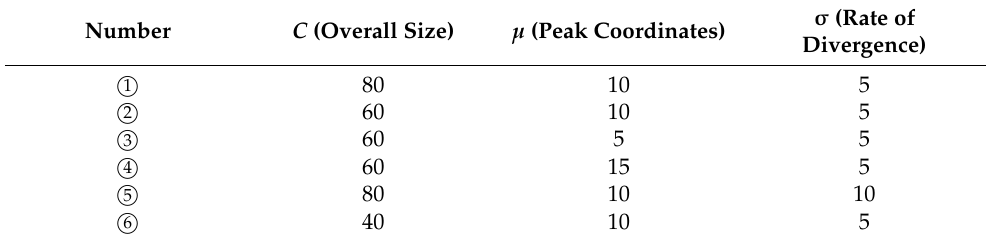
Table 6. The assignment of C , µ , σ under the normal